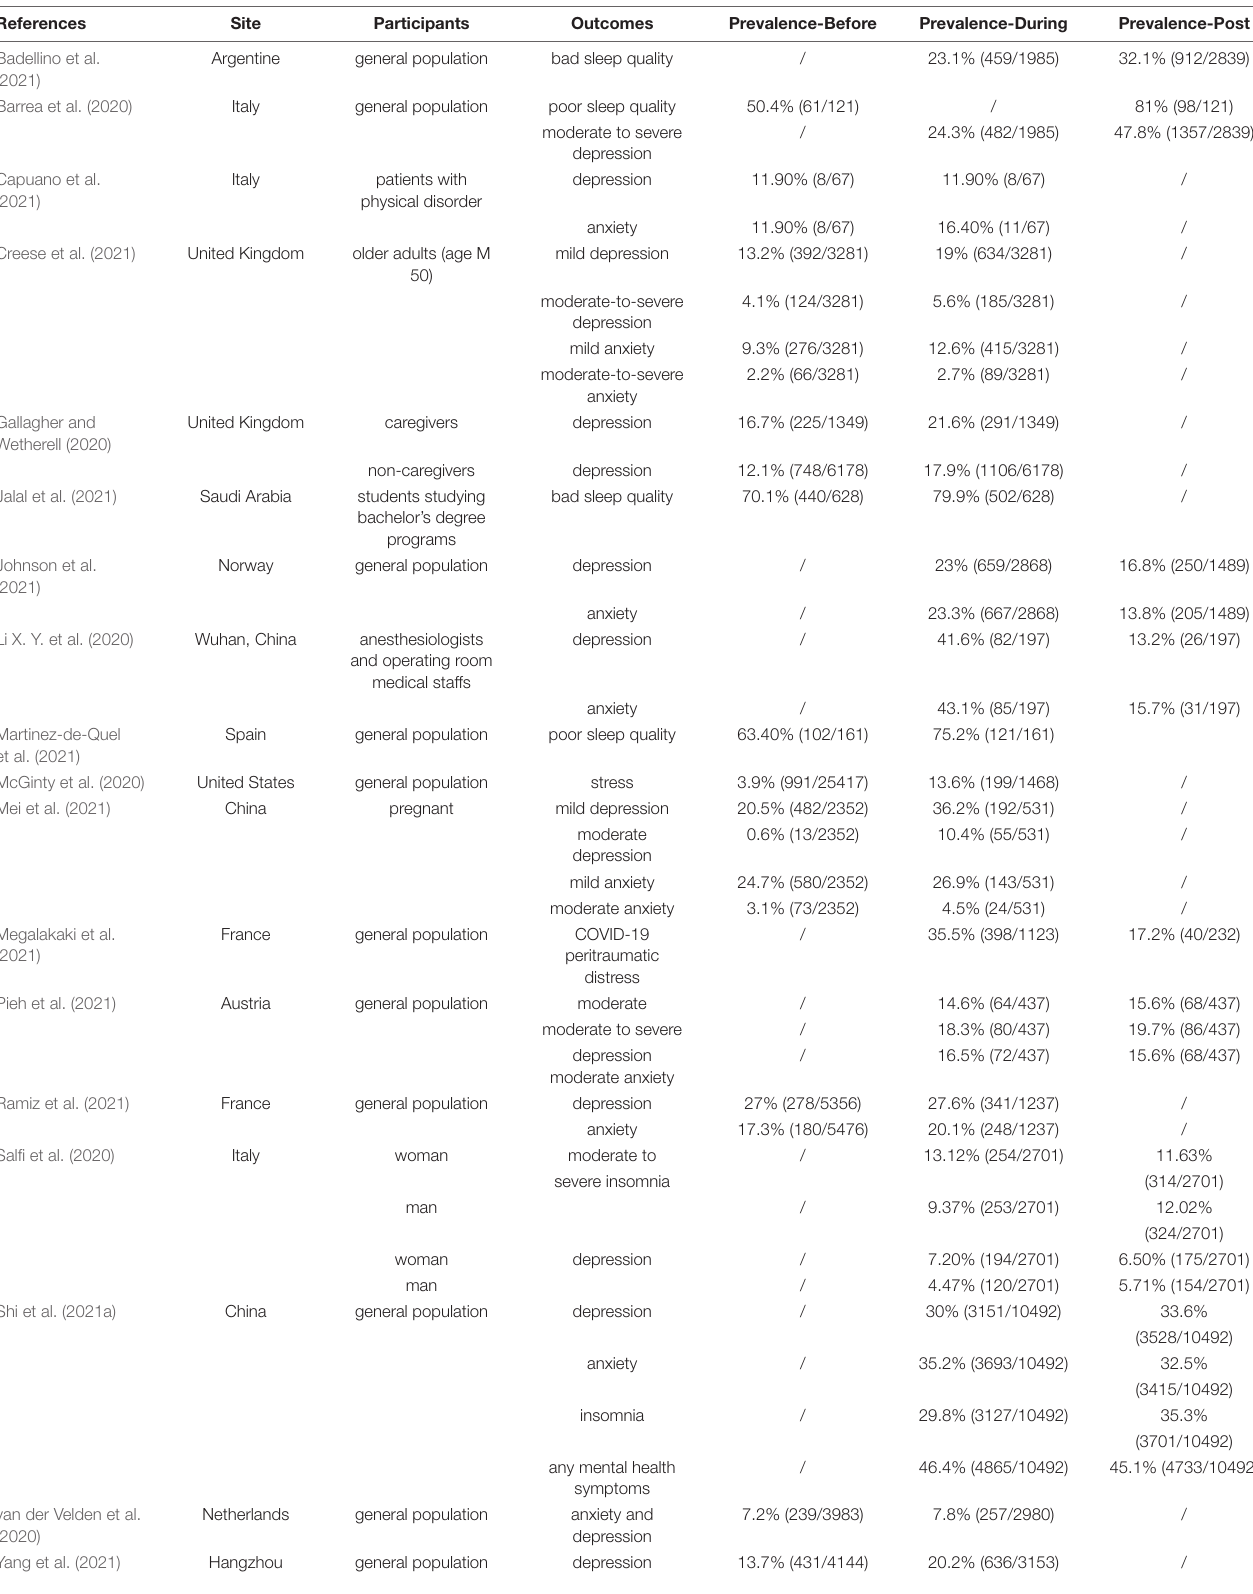
TABLE 1 | Summary of findings investigating prevalence of mental health problems relative to the COVID-19 outbreak